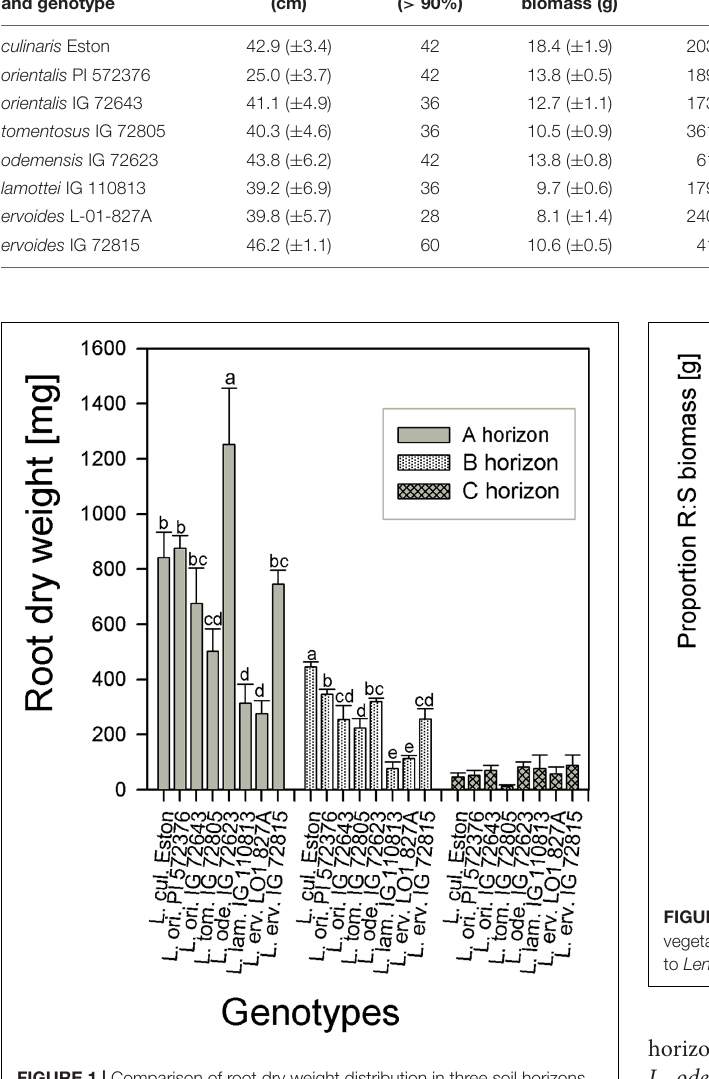
FIGURE 1 | Comparison of root dry weight distribution in three soil horizons for five wild lentil genotypes and Lens culinaris Eston. [Bar are standard errors and letters compare root dry weight between genotypes for the same soil horizon; no letters imply similar biomass].